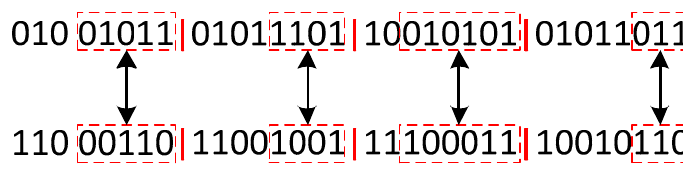
Figure 2. Multipoint crossover process.